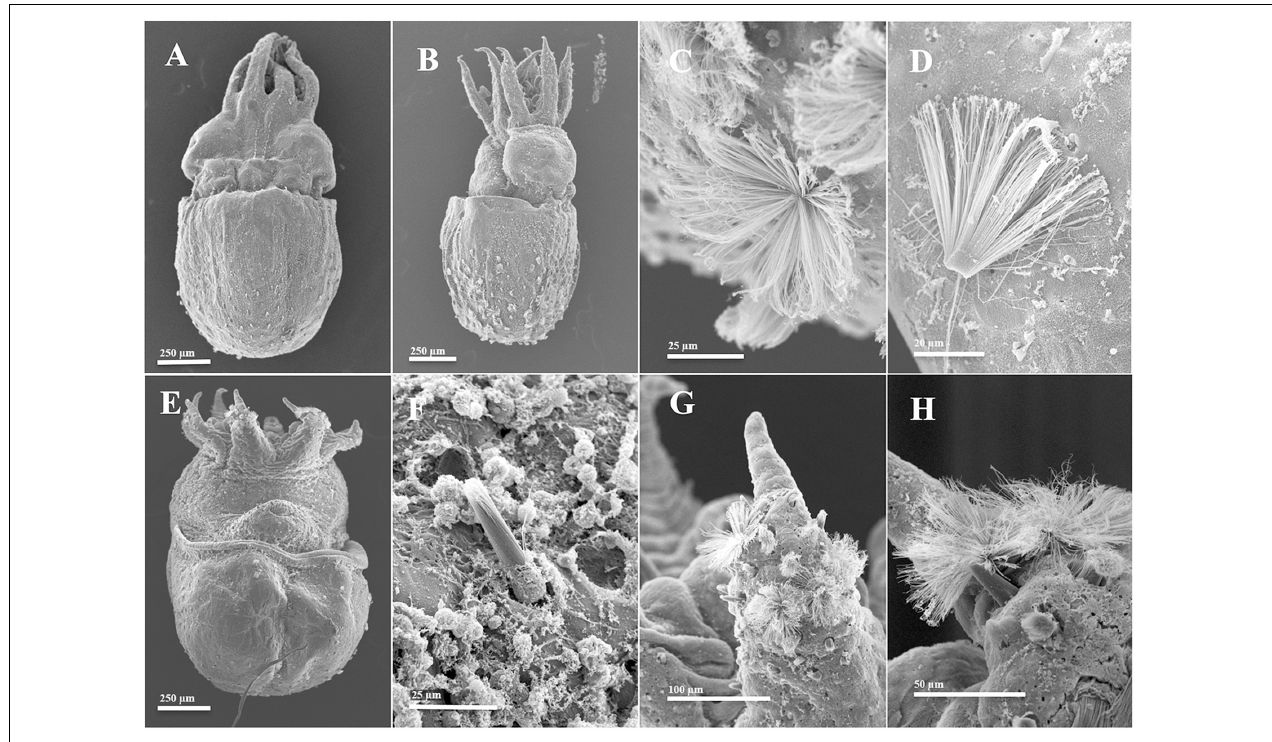
FIGURE 4 | Tritaxeopus abaculus hatchlings (A–D) and Octopus sinensis , age 12 days (E–H) SEM images. (A) dorsal view (ML 1.1 mm). Note erupted Kölliker’s organs (KO) on the mantle with their axis oriented obliquely with reference to the surface of the skin and directed anteriorly. Note also conspicuous dorsal line on each side close to midline, from head along arm I; (B) left lateral view (1.0 mm ML). Note everted KO on mantle surface and erupted KO over the arms; (C) detail of everted KO over the ventral mantle (same individual as B ); (D) tuft of ejected setae lying on ventral surface of head (ML 1.0 mm) possibly a handling artifact. (E) Ventral view (ML 0.9 mm) showing erupted KO on mantle, funnel, head and arms, and everted KO on ventral arms; (F) erupted KO on dorsal surface of head (ML 1.1 mm); (G,H) , detail of erupted and everted KO on tip of right (G) and left (H) ventral arms from the individual of image (E) .